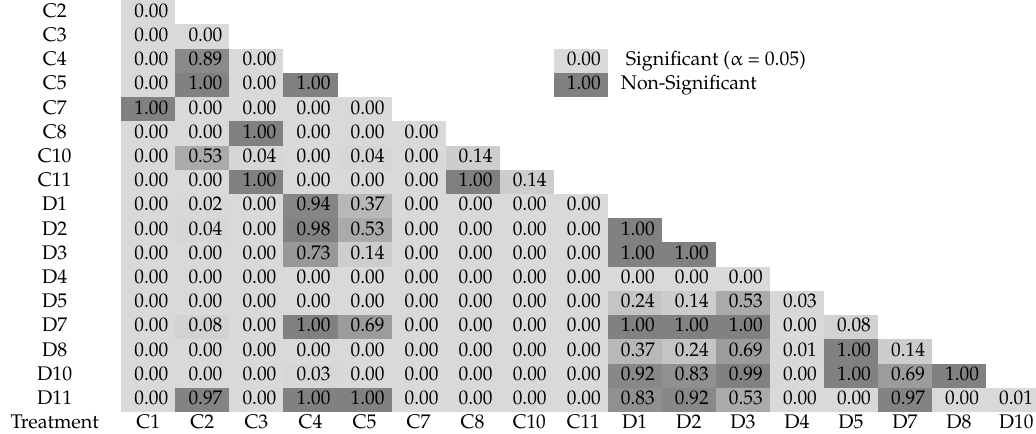
Note: light grey cells illustrate significant differences between pairs of treatments, while dark grey cells represent non-significant differences ( α = 0.05). D1 to D11 and C1 to C11 represent the different levels of burning and mowing treatments illustrated in Table 1.